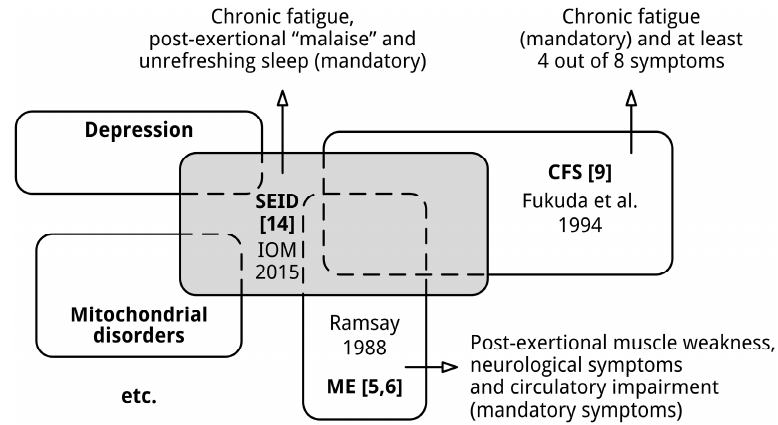
Figure 3. SEID overlaps with other (medical and psychiatric) conditions. The sizes of the shapes do not reflect the absolute sizes of various patient